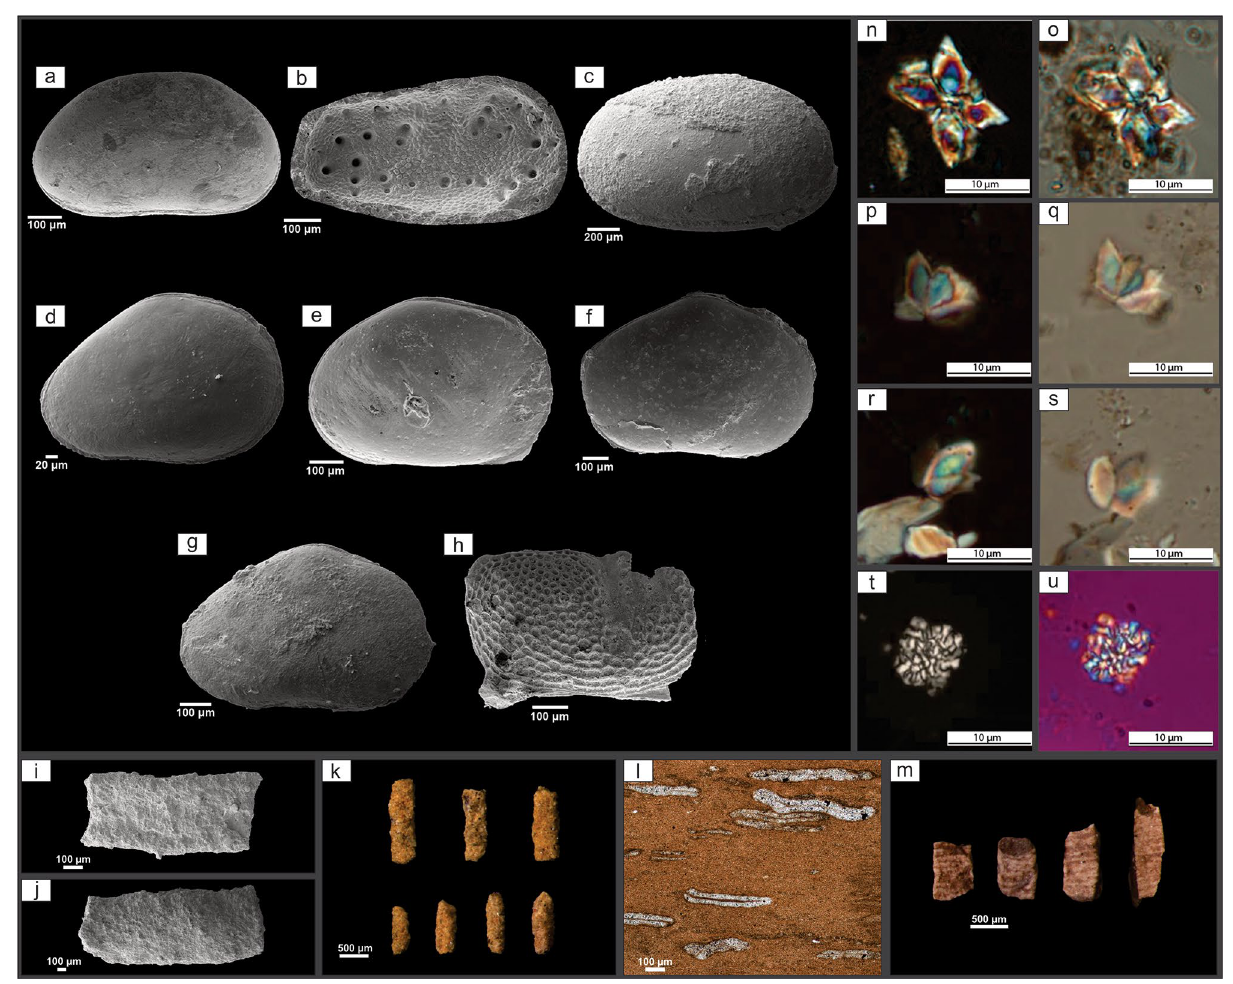
Figure 4. Plate illustrating key microfossil species recovered from boreholes 1PS-06-CE and 1PS-10-CE. Ostracods: ( a ) Candonopsis? alagoensis (right lateral view; 1PS-06-CE, 99.30 m); ( b ) Cypridea araripensis (mold; 1PS-10-CE, 51.20 m); ( c ) Brasacypris subovatum (right lateral view; 1PS-10-CE, 95.76 m); ( d ) Pattersoncypris alta (right lateral view; 1PS-06-CE, 99.30 m); ( e ) Pattersoncypris salitrensis (right lateral view; 1PS-06-CE, 99.30 m); ( f ) Pattersoncypris angulata 17 (1PS-06-CE, 99.30 m); ( g ) Pattersoncypris micropappilosa (right lateral view; 1PS-06-CE, 99.30 m); ( h ) Theriosynoecum silvai (right valve, 1PS-10-CE, 95.76 m). Foraminifera: ( i–m ) Bathysiphon sp. (( i,j ) 1PS-06-CE, 117.90 m; ( k–m ) 1PS-10-CE, 103.69 m, and 102.90 m). Calcareous nannofossils: ( n–s ) Ascidian spicule (1PS-06-CE, 99.30 m). ( t–u ) Thoracosphaera spp. (1PS-06-CE, 114.70